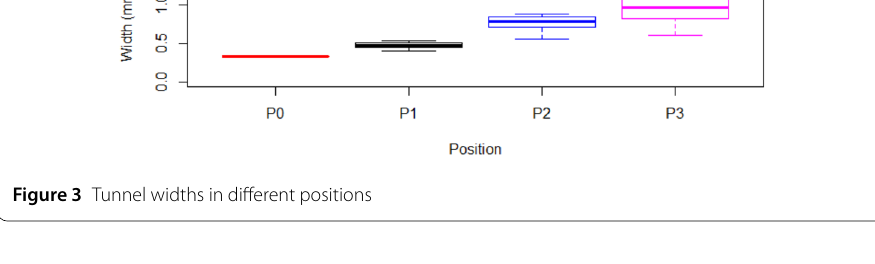
Figure 4 Starting points in the larval